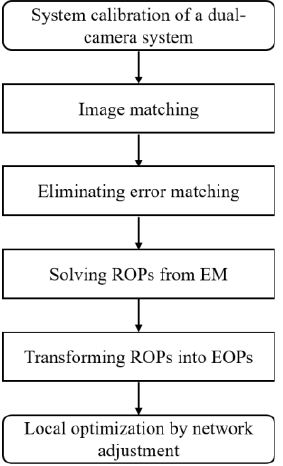
Figure 6. The workflow of proposed stereo